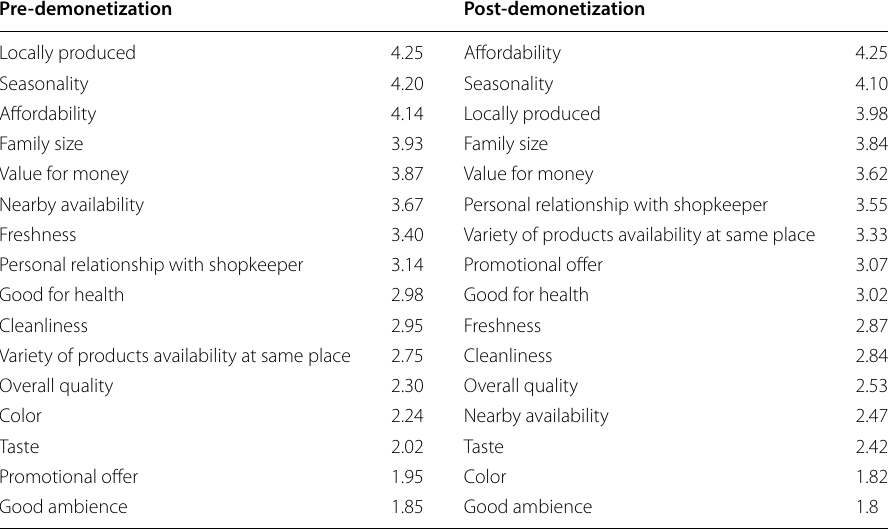
Table 10 Relative importance of food purchasing decision criteria of fruits and vegetables in